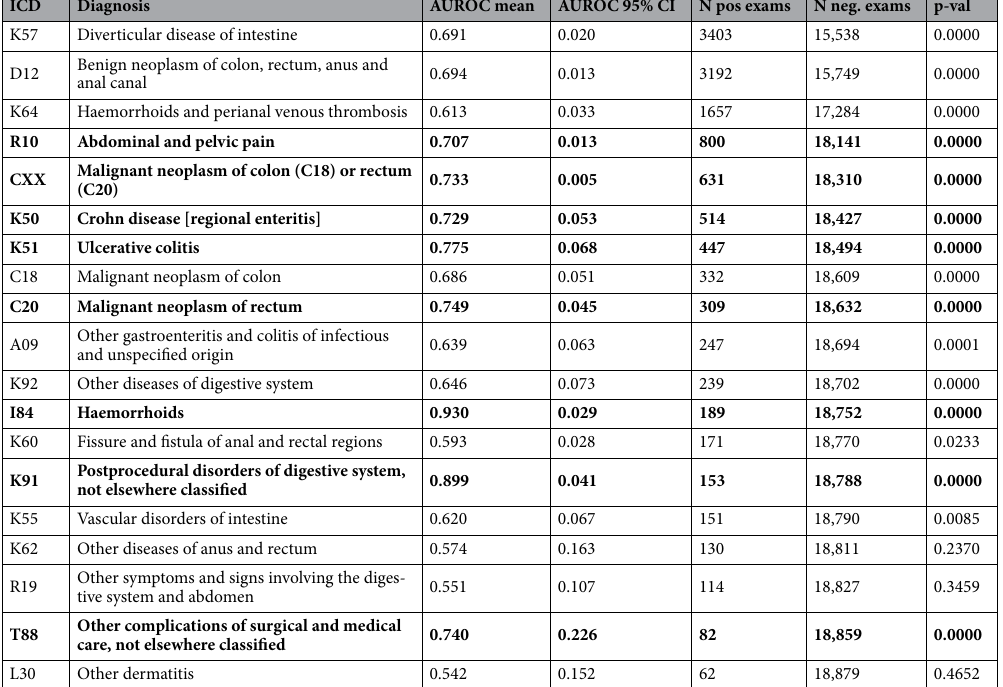
Table 2. Target diseases and classifier performance for the colonoscopy dataset. All targets which reached an area under the receiver operating curve (AUC, mean ± standard deviation [std]) of above 0.70 are highlighted in bold. N pos./neg. exams = number of positive/negative examinations (with and without diagnosis, respectively). P-val. P-value for examination scores between